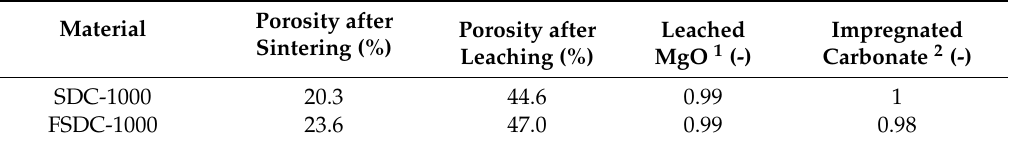
Table 3. SDC and FSDC pellets porosity all along the membrane preparation steps and fraction of leached MgO and impregnated carbonate.